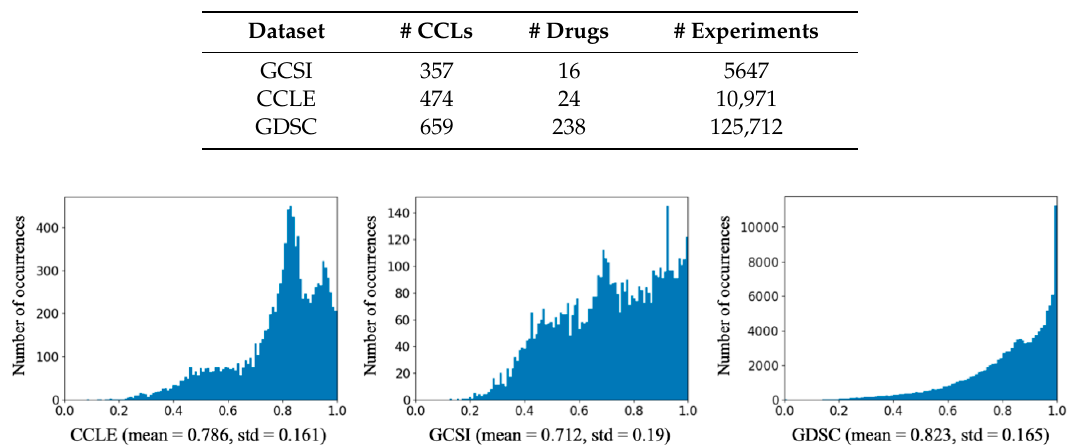
Table 2. Numbers of CCLs, drugs, and experiments (pairs of drugs and CCLs) in datasets.